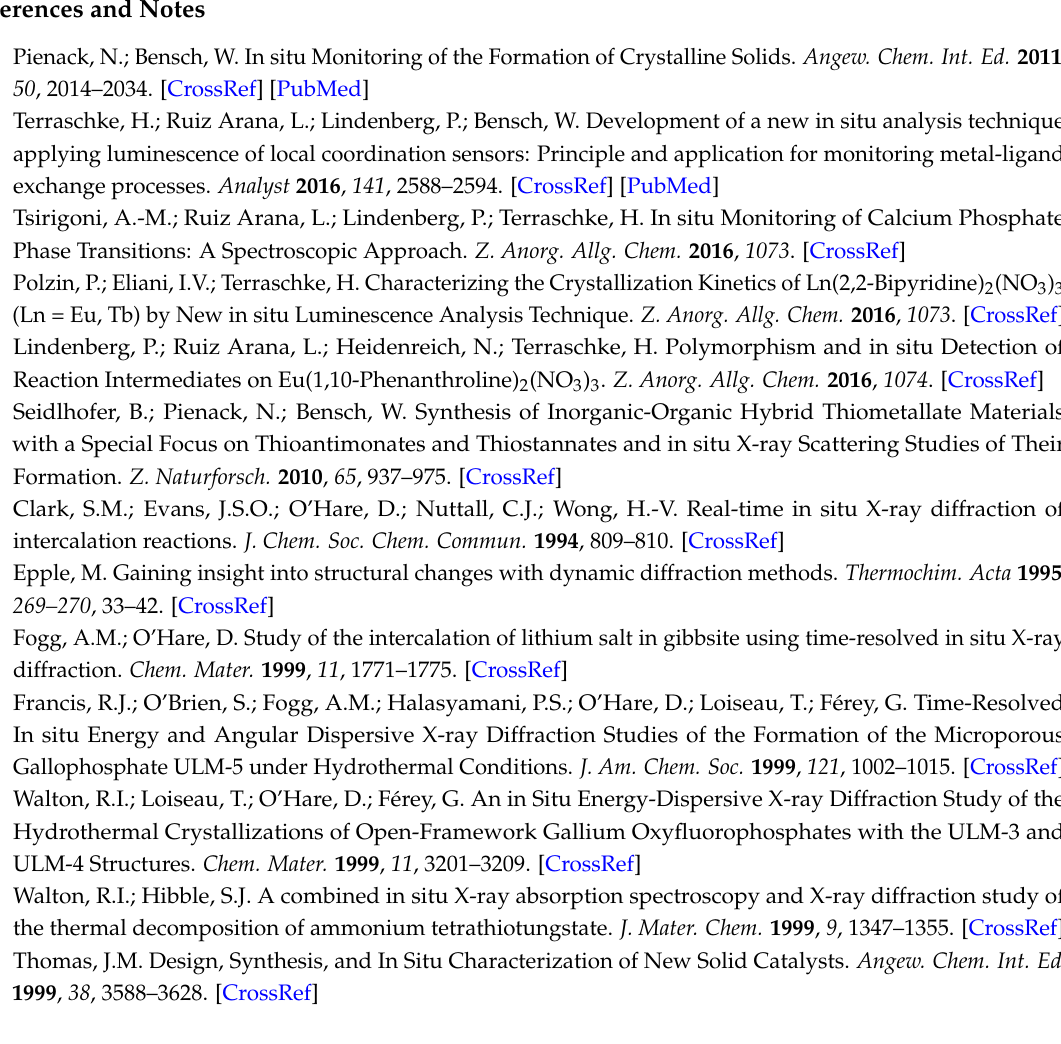
Figure S14: Comparison of light transmission intensity through the reaction solution for the crystallization of Al(acac) 3 by the addition of 2.5%, 12.5%, and 25% NH 3 solution. Figure S15: Setup of the crystallization cell in Kiel. The main parts of the equipment are marked. Figure S16: Adaptation of the crystallization cell in Kiel for in